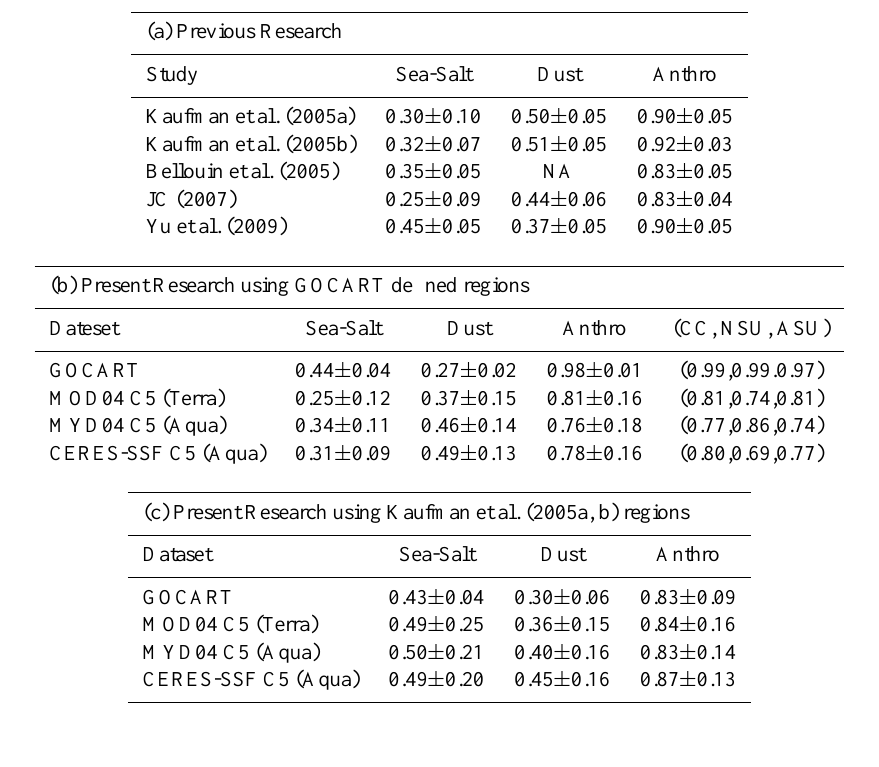
Table 1. (a) Comparison of aerosol FMF estimates from previous research for SS, DU, and AN aerosol types. (b) Average component FMF from the Aqua Collection 5 CERES-SSF and MYD04, and MOD04 satellite products as well as the GOCART simulations for the regions defined using GOCART. (c) Same as (b), but averaged over the regions defined in Kaufman et al. (2005a, b) and also in Yu et al. (2009). AN aerosols represents the combination of anthropogenic sulfates and all carbonates. FMF values in parenthesis indicate average FMF values for CC, NSU, and ASU aerosol components, where available. Variability listed for this research represent the standard deviation of FMF within a particular aerosol component